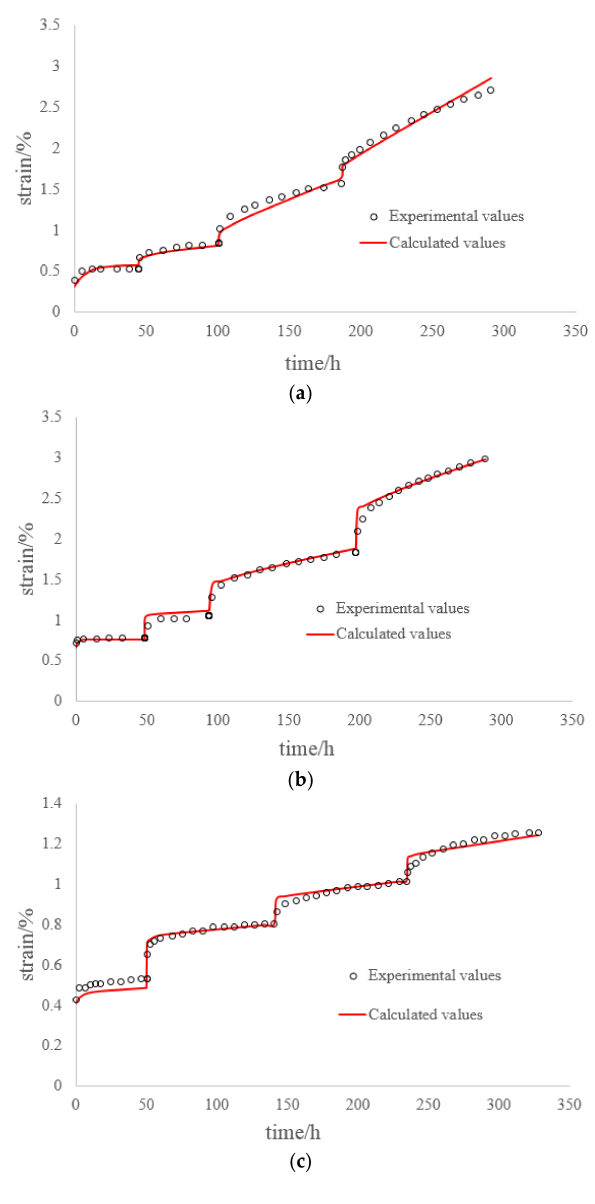
Figure 17. Comparison of the Nishihara model and experimental curves under single-step